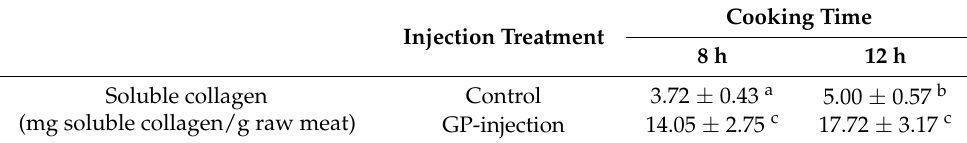
Table 6. Effect of injection treatment (GP injection = ginger powder injection containing zingibain; control = without injection) and cooking time (8 h, 12 h) on soluble collagen of M. biceps femoris cooked at 65 ◦ C under sous vide. Values are presented as mean ± SE. Superscripts refer to signifi- cant differences in the mean values ( p < 0.05). A similar letter describes non-significance between